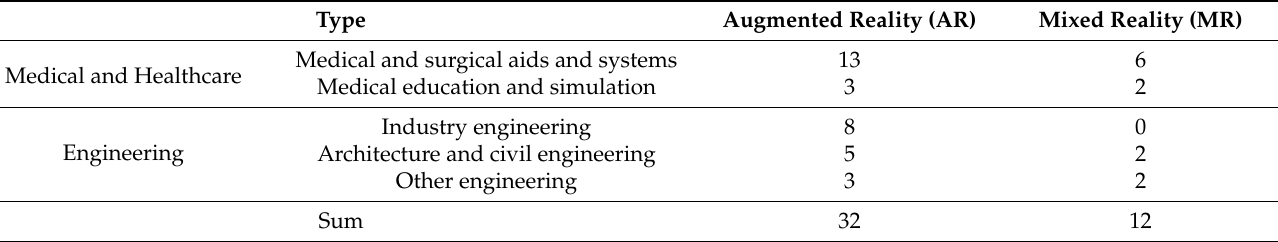
Table 7. Numbers of reviewed studies by visualization types used in medical and healthcare and engineering fields. Type Augmented Reality (AR) Mixed Reality (MR) Medical and